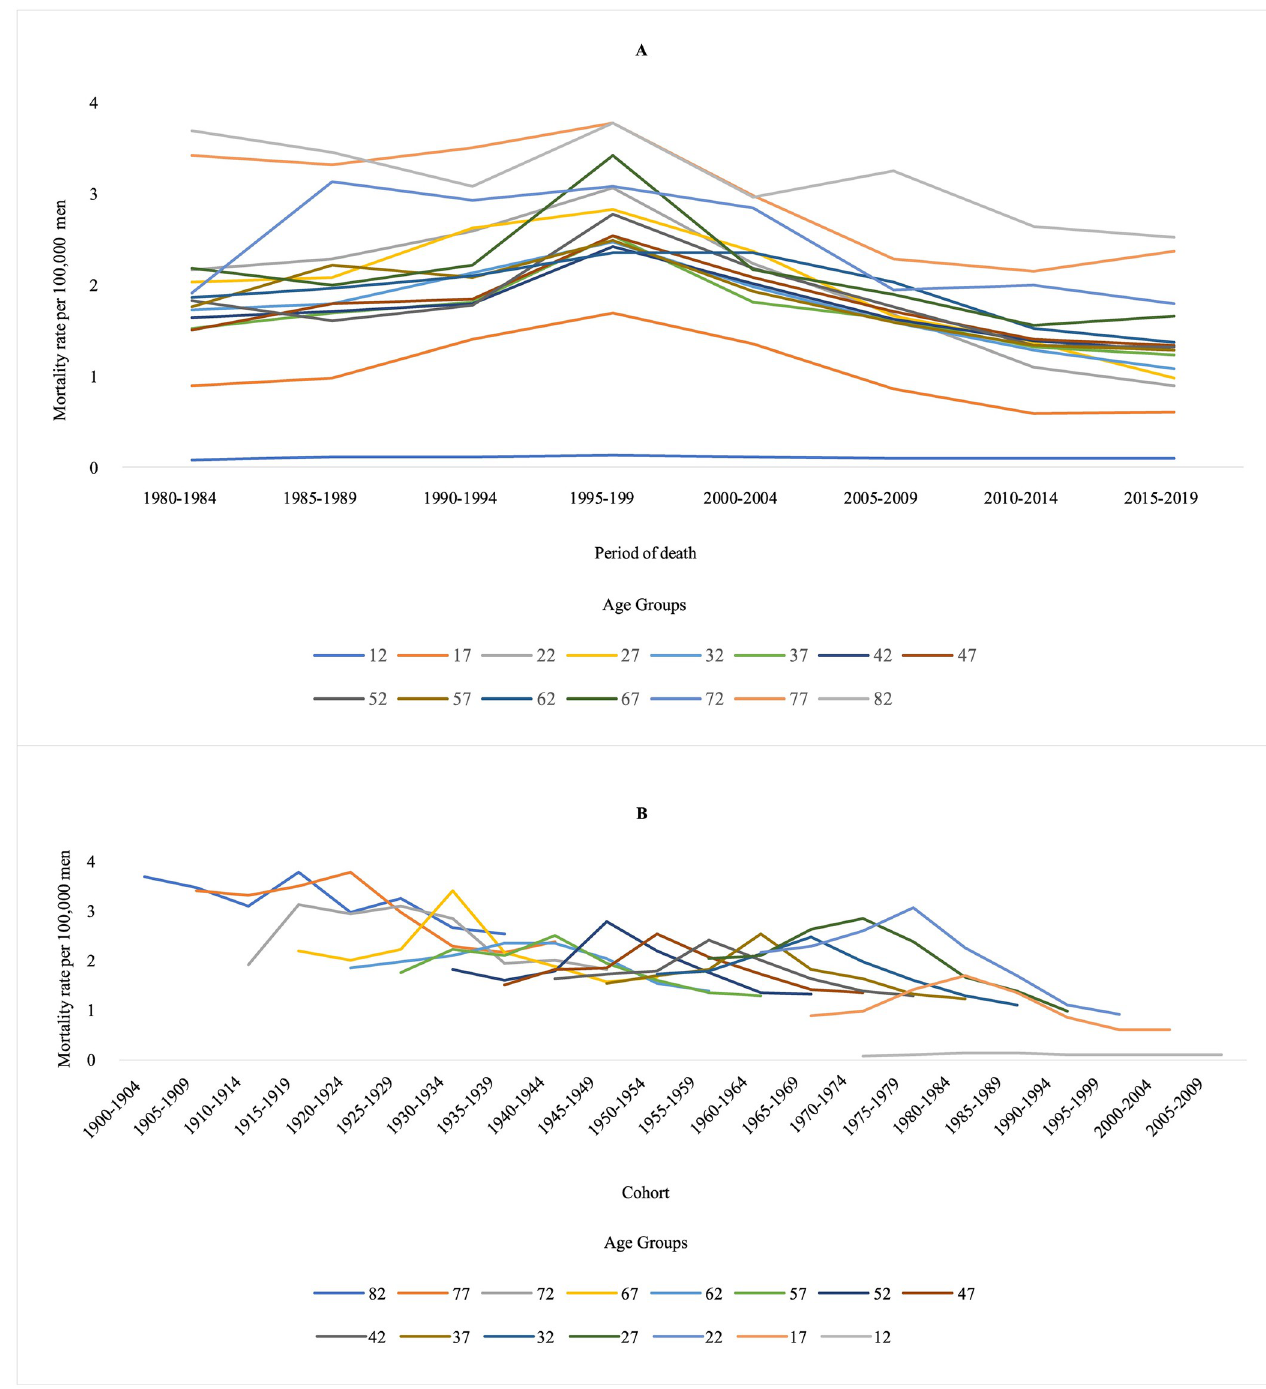
Fig 3. Suicide by firearms mortality rates per 100,000 men in Brazil, according to age group, period, and cohort, from 1980 to 2019.